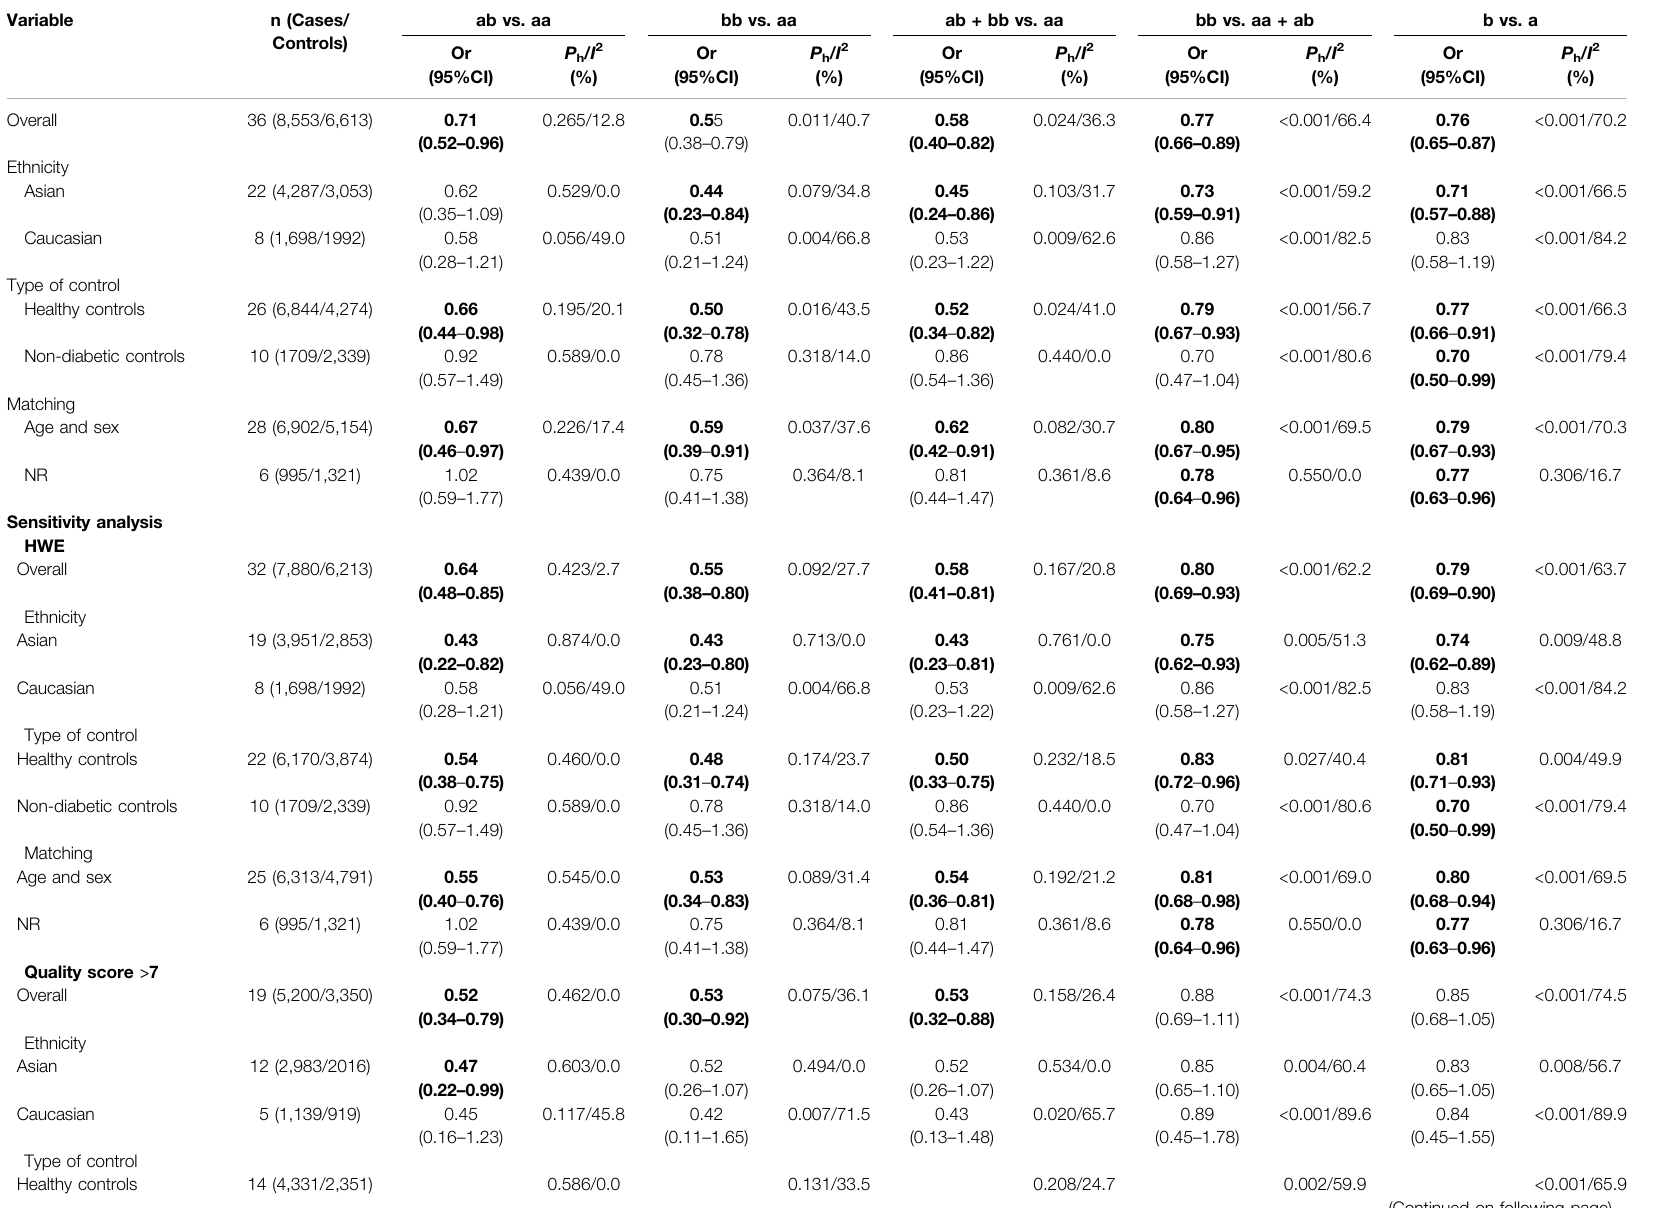
TABLE 6 | Meta-analysis of the association of eNOS 4b/4a polymorphism with risk of